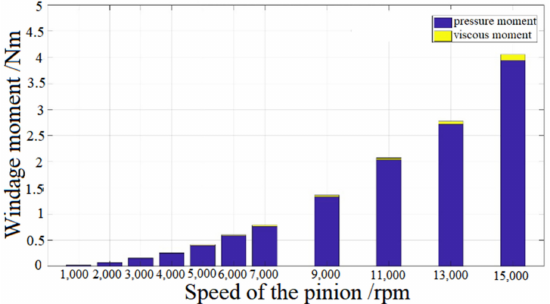
Figure 8. Moment compared against different speeds of the